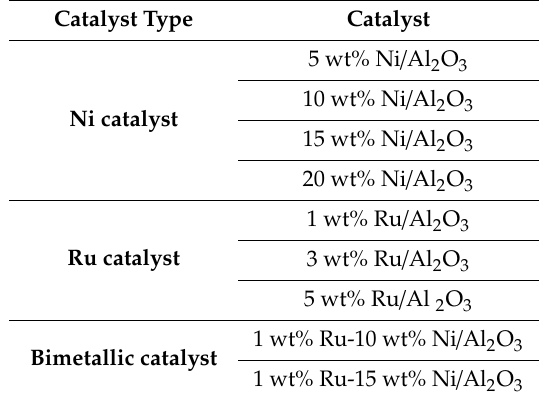
Table 1. Abbreviation and metal loading amount for Al 2 O 3 -supported Ni, Ru, and Ru-Ni catalysts.